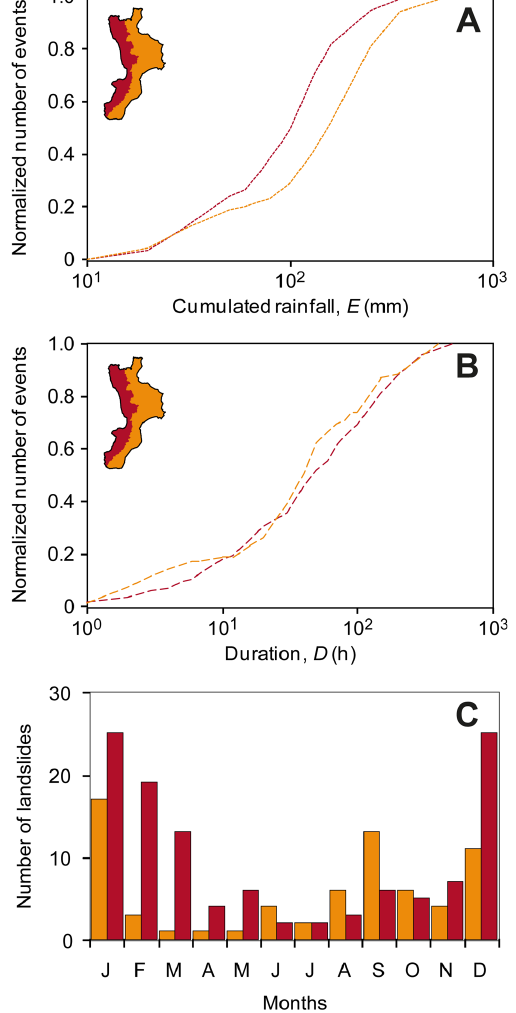
Fig. 9. Frequency of (A) the cumulated event rainfall and (B) the du- ration of the events, for the Tyrrhenian and the Ionian alert regions. (C) Monthly distribution of landslides in the two alert regions.